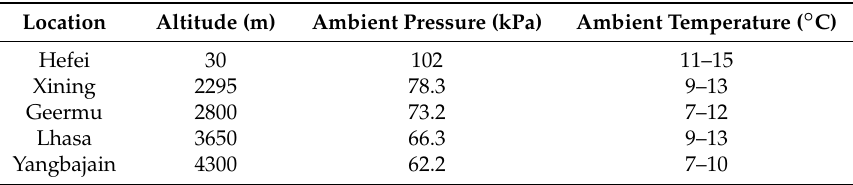
Table 1. Atmosphere parameters at five different altitudes.